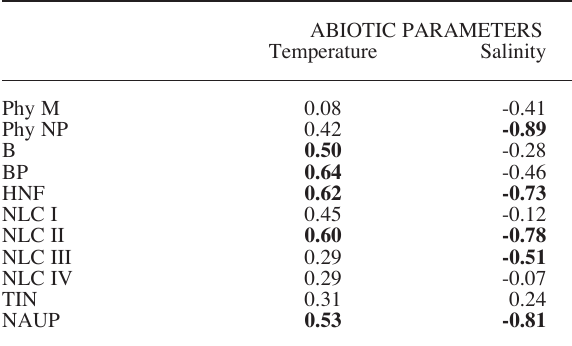
T ABLE 1 . – Pearson’s correlation coefficients between biomass val- ues of bacteria, heterotrophic nanoflagellates, ciliates, copepod nau- plii, concentration of phytoplankton chlorophyll a and bacterial pro- duction and temperature and salinity (Significant correlation coefficients are printed in bold; N=18, P<0.05).